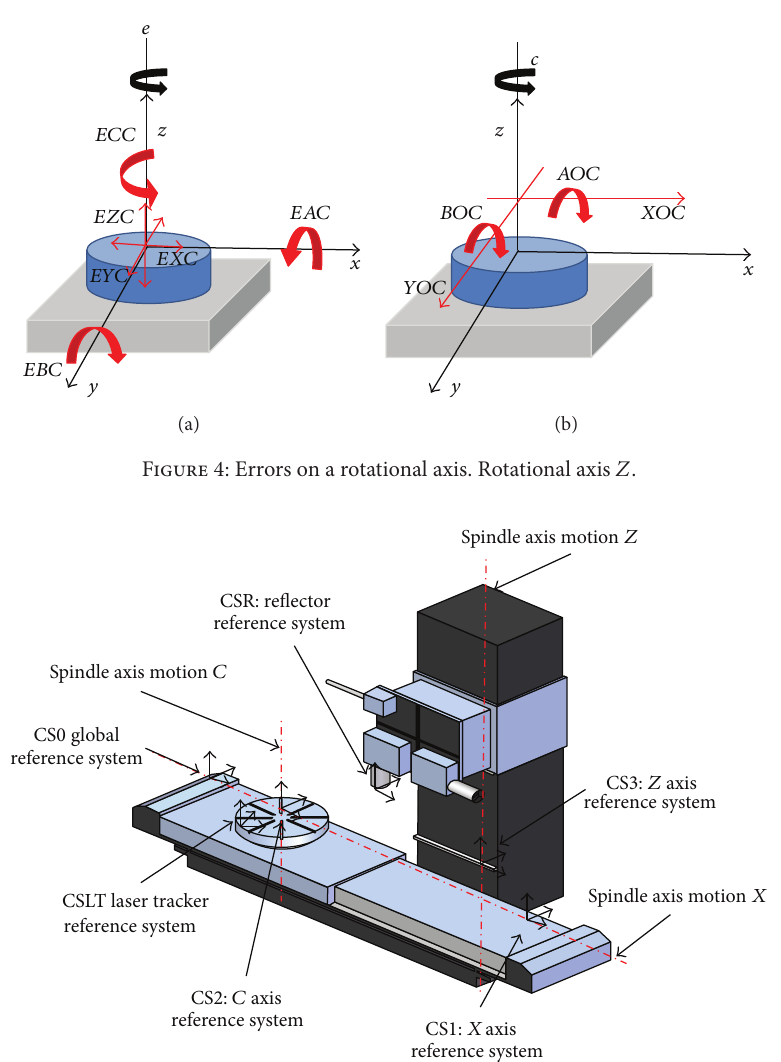
Figure 5: Machine tool XCFZ to